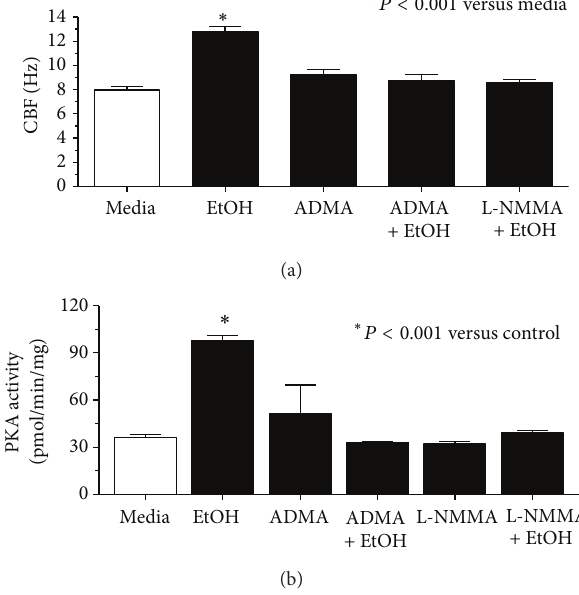
Figure 3: ADMA blocks alcohol-stimulated increases in both CBF and PKA activity in bovine bronchial epithelial cells. (a) Cilia beat frequency (CBF) in primary bovine bronchial epithelium treated with 100mM alcohol (EtOH). Pretreatment (30min) with ADMA (100 𝜇 M) blocked 1hr alcohol stimulation of CBF ( 𝑃 < 0.001 ) versus control media. This inhibition was comparable to that observed with the NOS blocker (L-NMMA; 10 𝜇 M). (b) ADMA pretreatment blocks alcohol-stimulated increases in PKA activity in ciliated bovine epithelium ( ∗ 𝑃 < 0.001 ). Bars represent SEM of triplicate separate experiments ( 𝑛 = 3